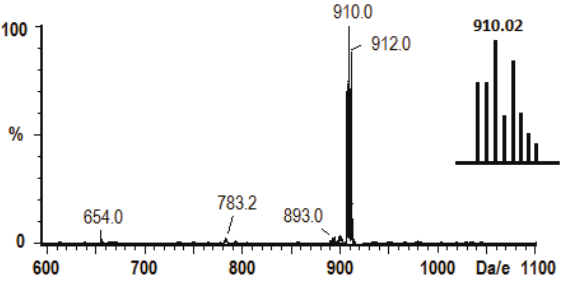
Figure 1: ES-MS spectra in negative mode of the complexes [W{S C (Ph) } ] ( 1 ) in acetone:water (70:30). Inserts: the theoretical 2 2 2 3 isotopic distribution of complex 1 .